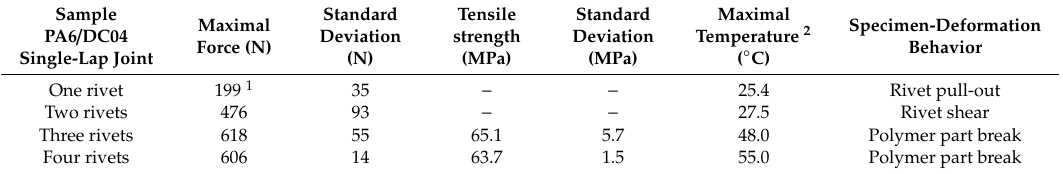
Table 1. Mechanical results of single lap-joint test for samples with rivets with information about nature of sample damage. For each tensile test, six samples were used.